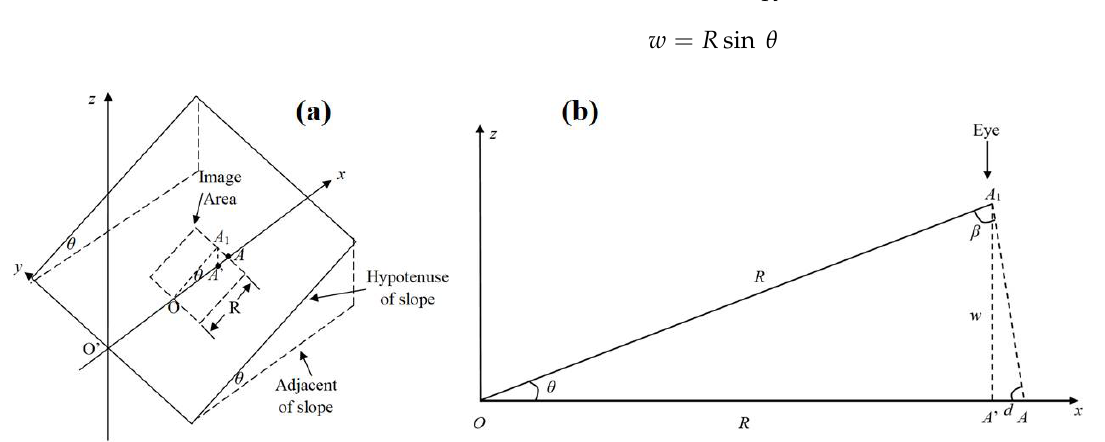
Figure 3. The simplest slope model: ( a ) plan view; ( b ) cross-sectional view.